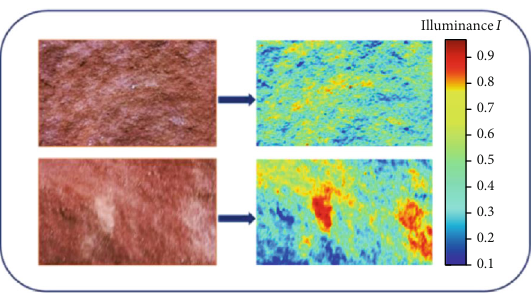
Figure 3: Image normalization.